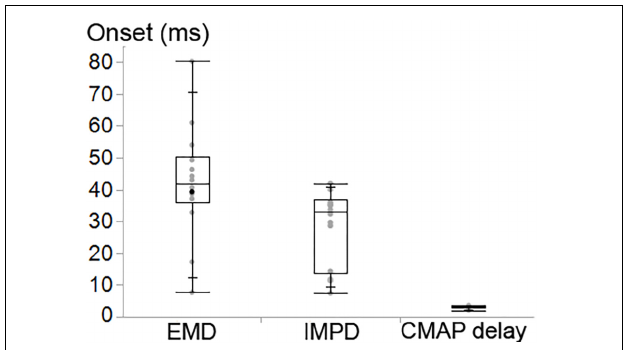
FIGURE 8 | Box and whisker plot of the onset delay of the ankle torque (EMD), the intramuscular pressure (IMPD) and CMAP of tibialis anterior